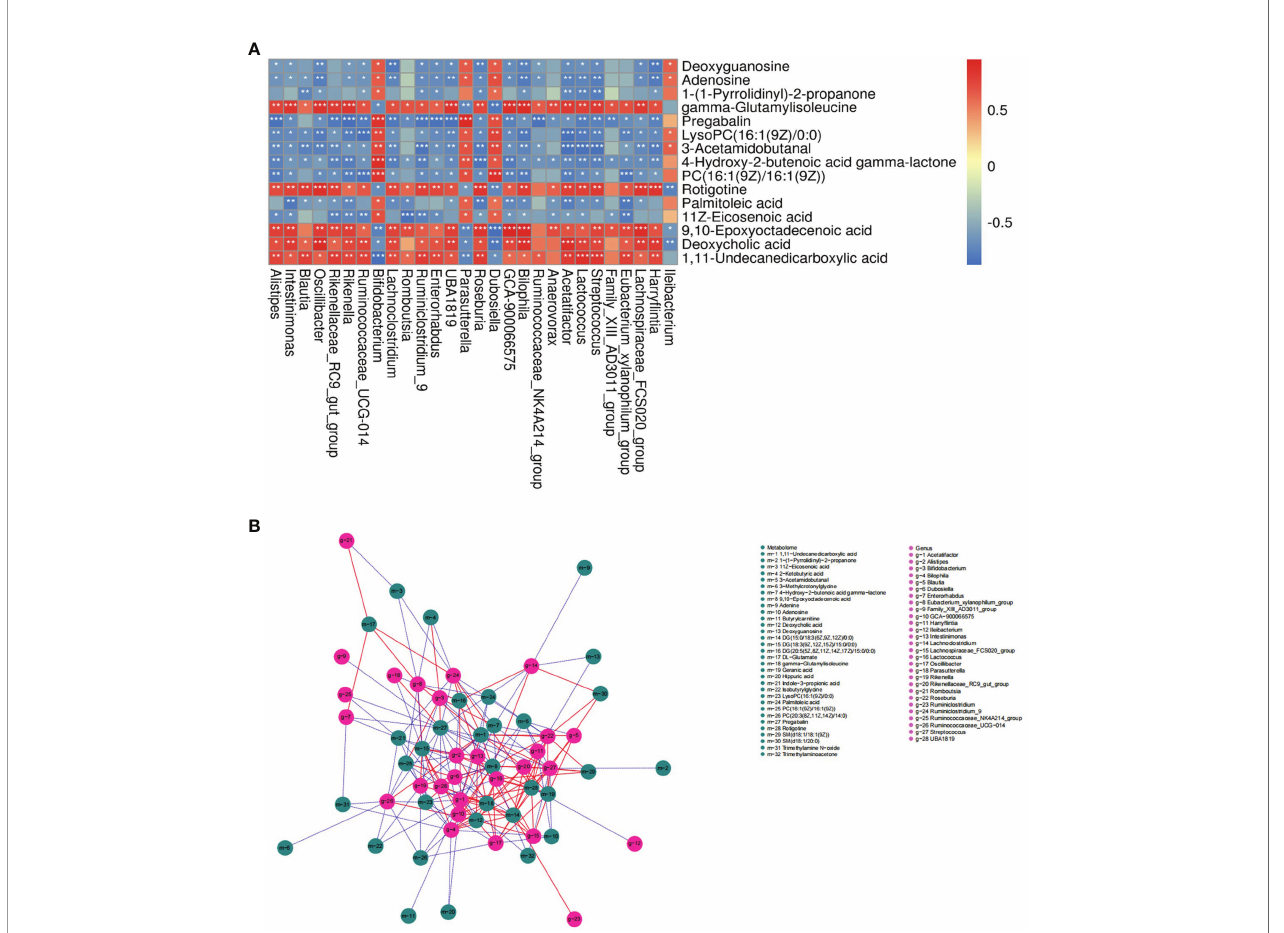
FIGURE 6 | Association analysis of serum metabolome and gut microbiota. (A) Heat map of correlation between differentially expressed bacterial genera and metabolites in the ND and HFD group (|r|>0.6). * P < 0.05, ** P < 0.01, *** P < 0.001. (B) Network map of the top 200 correlations between bacterial genera and serum metabolites related to bone phenotypes (|r|>0.5). A solid red line indicates a positive correlation; a dashed blue line indicates a negative